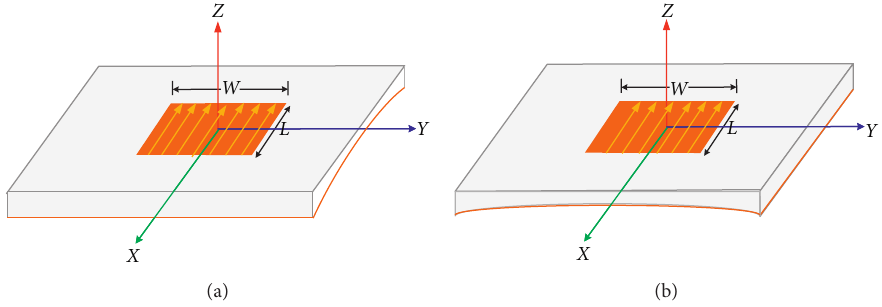
Figure 6: Current distribution of air microstrip antenna. (a) XOZ plane deformation. (b) YOZ plane